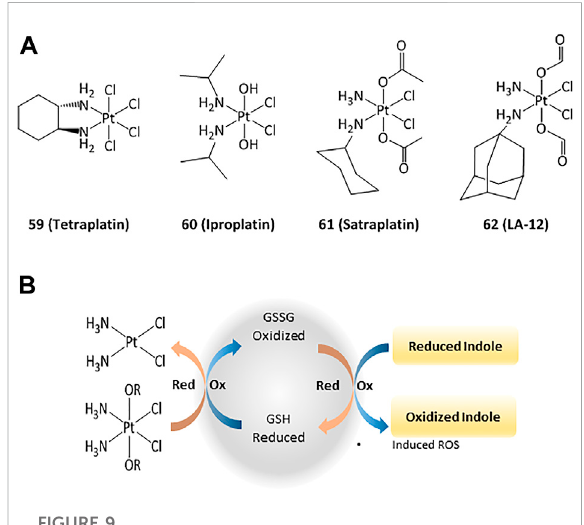
FIGURE 9 Pt(IV) anticancer drugs that have entered clinical trials (A) and redox interaction of Pt(IV) complexes and glutathione (B)